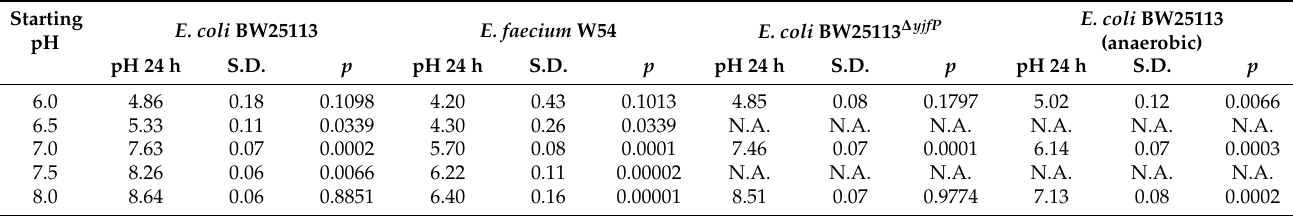
Table 2. pH measurements in pure bacterial cultures. Summary table of pH values measured in pure bacterial cultures after 24 h of incubation with 50 µ M methylphenidate at different starting pH values. Standard deviation (S.D.) represents 3 biological replicates. Unpaired t -test was performed to compare methylphenidate hydrolysis in bacterial cultures to the corresponding pH controls in bacterial growth